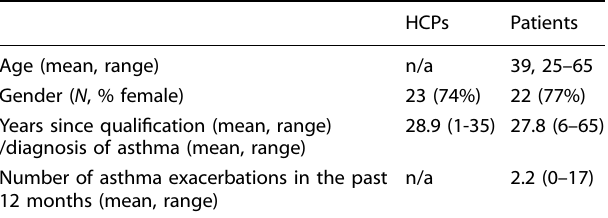
Table 1. Summary of HCP and patient